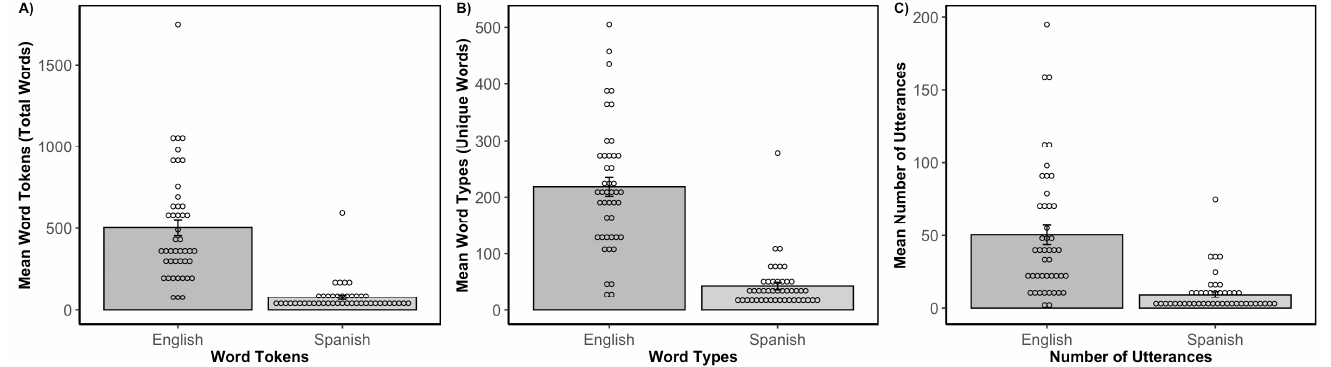
Figure 1. Mean (and standard error of the mean) for ( A ) Word tokens, ( B ) Word types, and ( C ) Number of utterances for English and Spanish within picture books in our sample. Dots represent individual picture books.